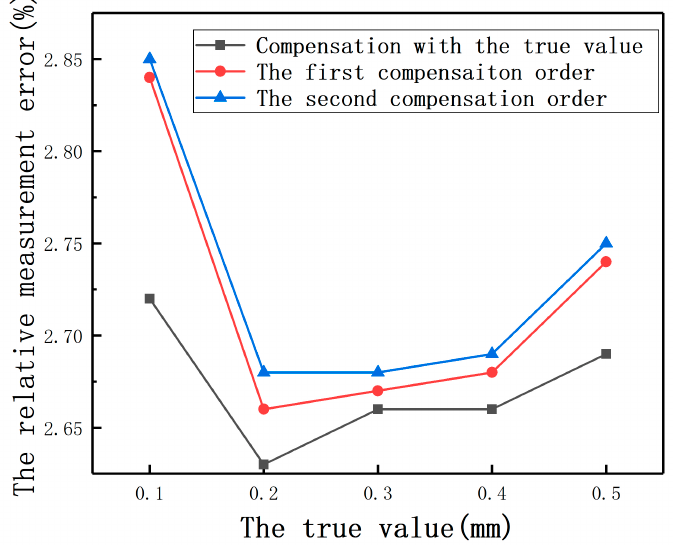
Figure 38. The relative measurement errors under different compensation sequences.